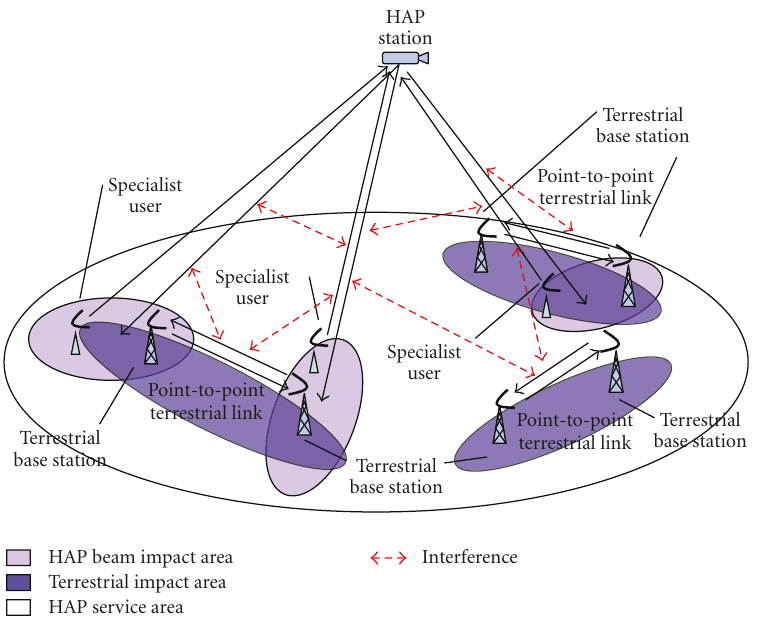
Figure 1: The single HAP with multiple-directional antennas and terrestrial point-to-point